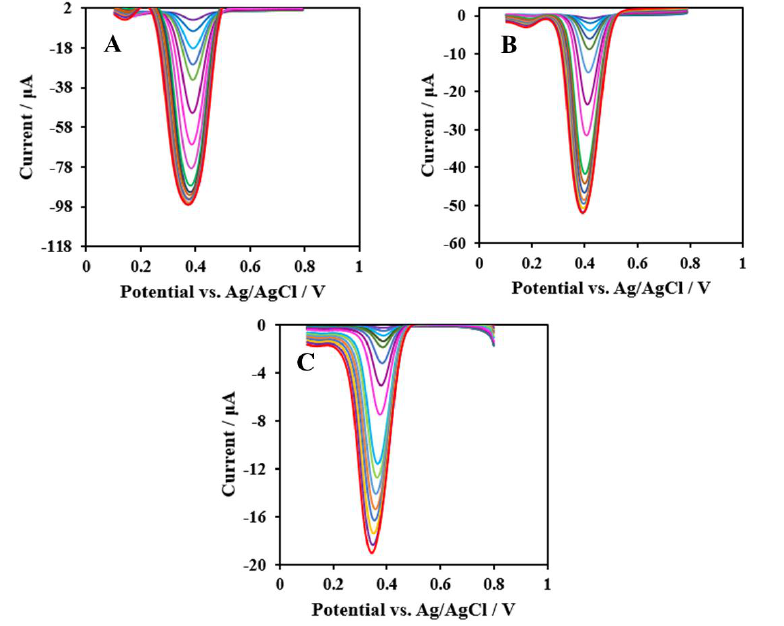
Figure 6. ( A ) SWV, ( B ) DPV, and ( C ) LSV of NF/IL/CMC-MWCNTs/GCE for the reduction response of rutin at different concentrations (0.1 μM–20 μM).